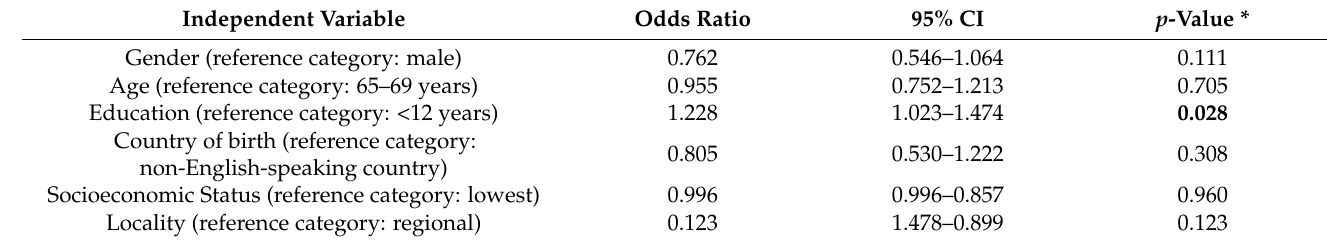
Table 4. Predictors of dementia-related beliefs based on binary logistic regression ( n =